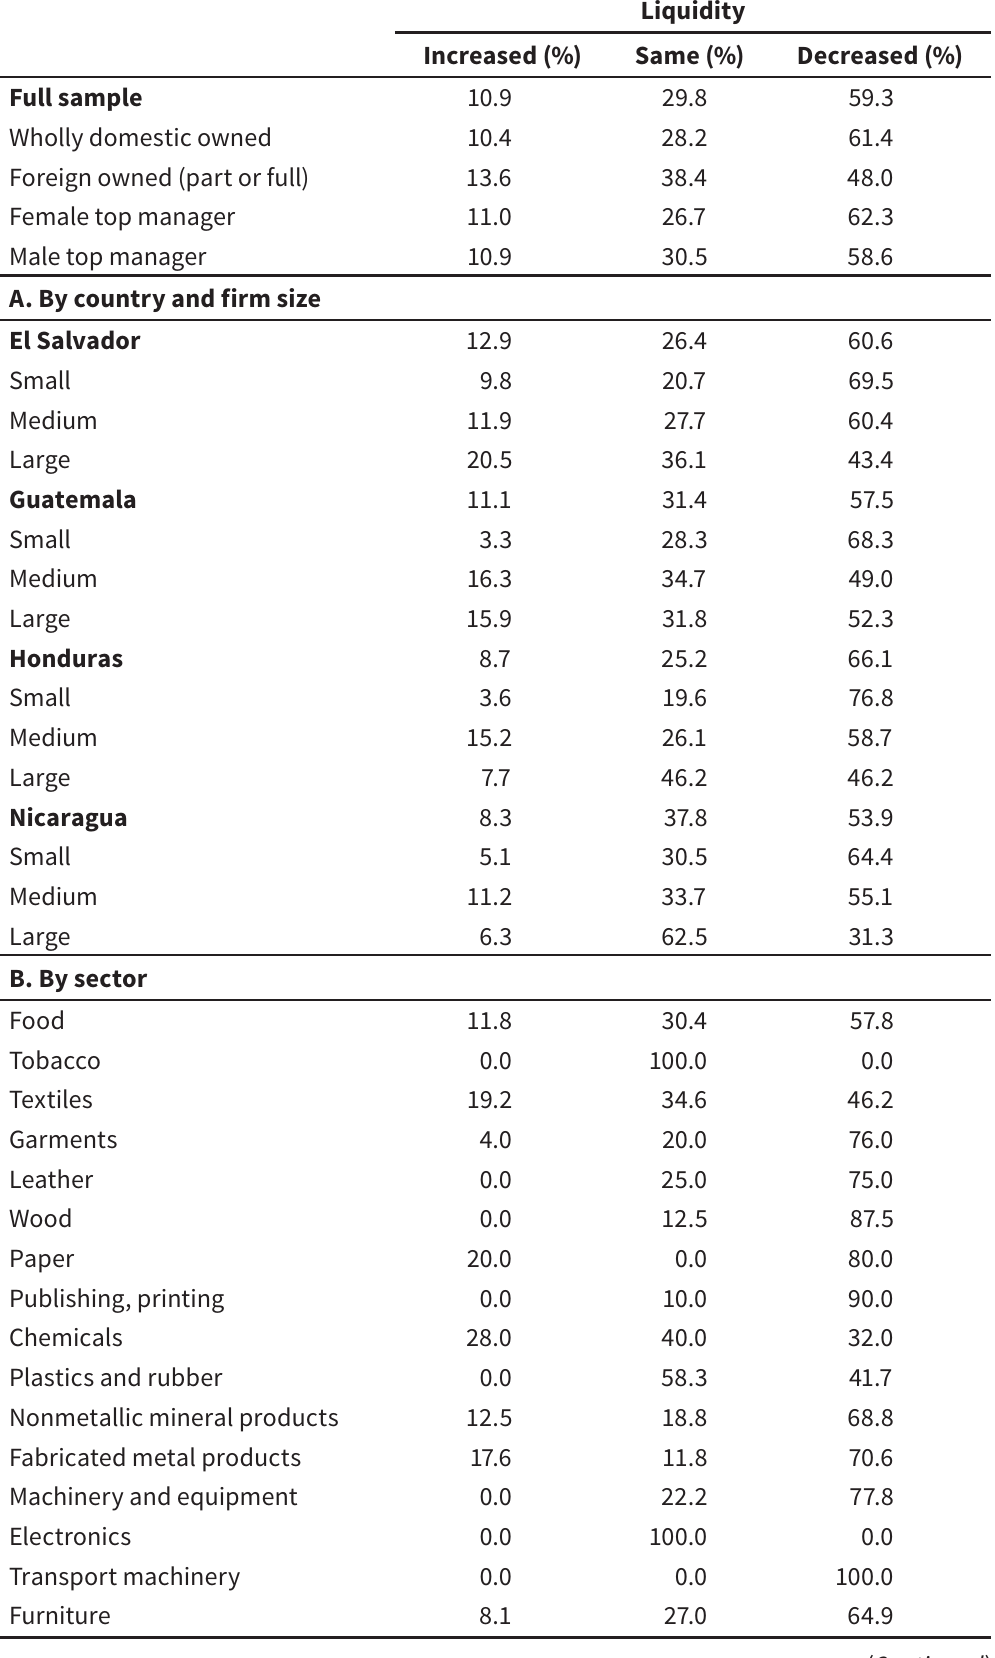
Changes in liquidity since the outbreak of COVID-19 (percentage of firms)*